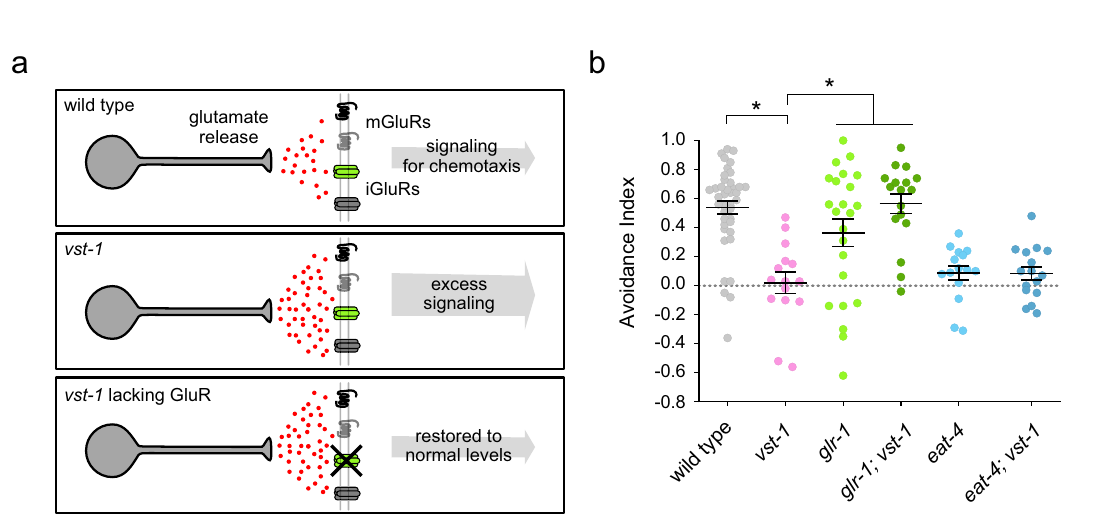
Fig. 3 VST-1 inhibits EAT-4/VGLUT-dependent glutamate release from BAG neurons and acidi fi es synaptic vesicles. a – d iGluSnFR signal ( Δ F / F ) from neurites of BAG neurons in culture expressing the glutamate sensor iGluSnFR. Individual traces are plotted in gray and the mean signal is plotted in black. Neurons were depolarized with a fi ve second pulse of 100 mM KCl. BAG neurons were isolated from the a wild type ( n = 32), b eat-4(ky5) mutants ( n = 19), c vst-1(gk673717) mutants ( vst-1 1 ) ( n = 34), and d vst-1(gk308047) mutants ( vst-1 2 ) ( n = 26). e Mean iGluSnFR signals from wild-type, eat-4 , and vst-1 BAG neurons. Line under traces indicates KCl application. The overlay shows increased glutamate release from vst-1 neurons and no glutamate release from eat-4 neurons. f Quanti fi cation of iGluSnFR signals (mean ± SEM) from wild-type and mutant BAG neurons shown in a – d . Cumulative signal between 10 and 20 s was computed for each trial. * P < 0.05 for comparisons of the mutants to wild type as determined by a Kruskal – Wallis test and corrected for multiple comparisons via Dunn ’ s test ( P -values for each comparison marked with an asterisk (*) — wild type vs. eat-4 : 0.0004; wild type vs. vst-1 1 : 0.0035; wild type vs. vst-1 2 : 0.0006). g Measurement of total synaptopHluorin and surface-accessible synaptopHluorin used to compute vesicular pH. Change of synaptopHluorin signal ( Δ F / F ) of an example KCl-responsive punctum in response to NH 4 Cl and MES over time is shown. These measurements were used to compute lumenal pH according to Mitchell et al. 68 . h Synaptic vesicle pH (mean ± SEM) of wild type, vst-1 2 mutants, and eat-4 mutant BAG neurons ( n = 112, 71, and 110, respectively). * P < 0.05 for comparisons of the mutants to wild type as determined by one-way ANOVA corrected for multiple comparisons via Dunnett ’ s test (the pH of all genotypes have a normal distribution, P -value for each comparison — wild type vs. vst-1 2 : 0.041 wild type vs. eat-4 : 0.93).